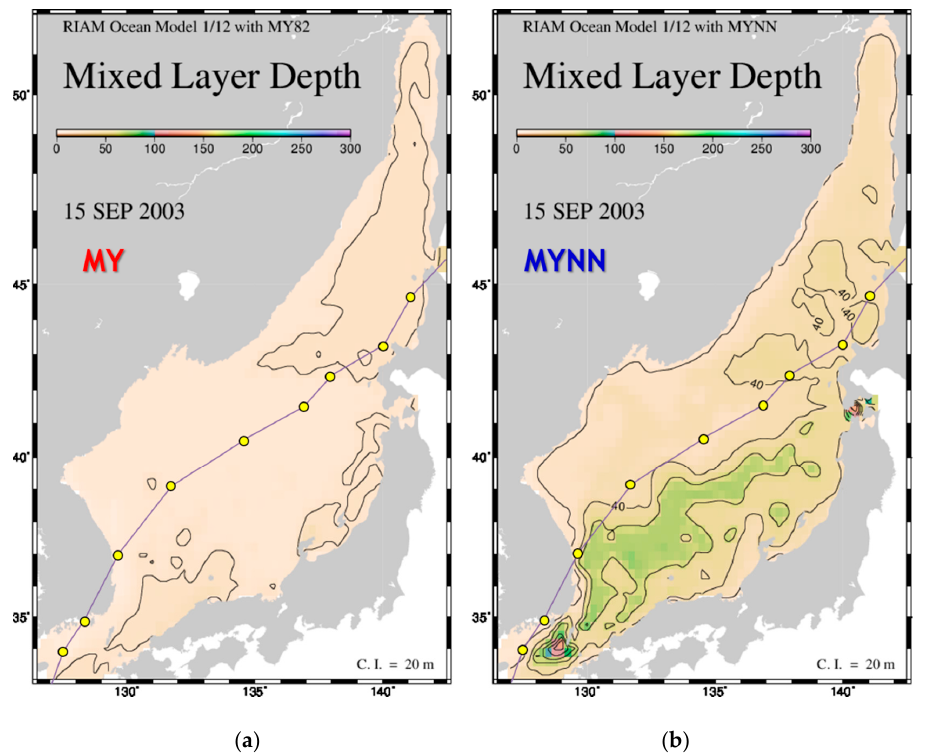
Figure 6. Horizontal distributions of the mixed layer depth calculated using ( a ) the Mellor–Yamada (MY) and ( b ) the Mellor–Yamada–Nakanishi–Niino (MYNN) models on September 15, 2003. The solid purple lines with yellow circles show the track of Typhoon Maemi. The contour interval is 20 m. The bottom of the surface mixed layer is defined at the depth where the potential temperature becomes lower than that at the sea surface by 0.5 °C.